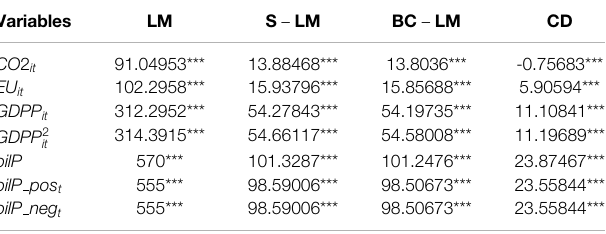
TABLE 2 | Results of cross-sectional dependence tests.